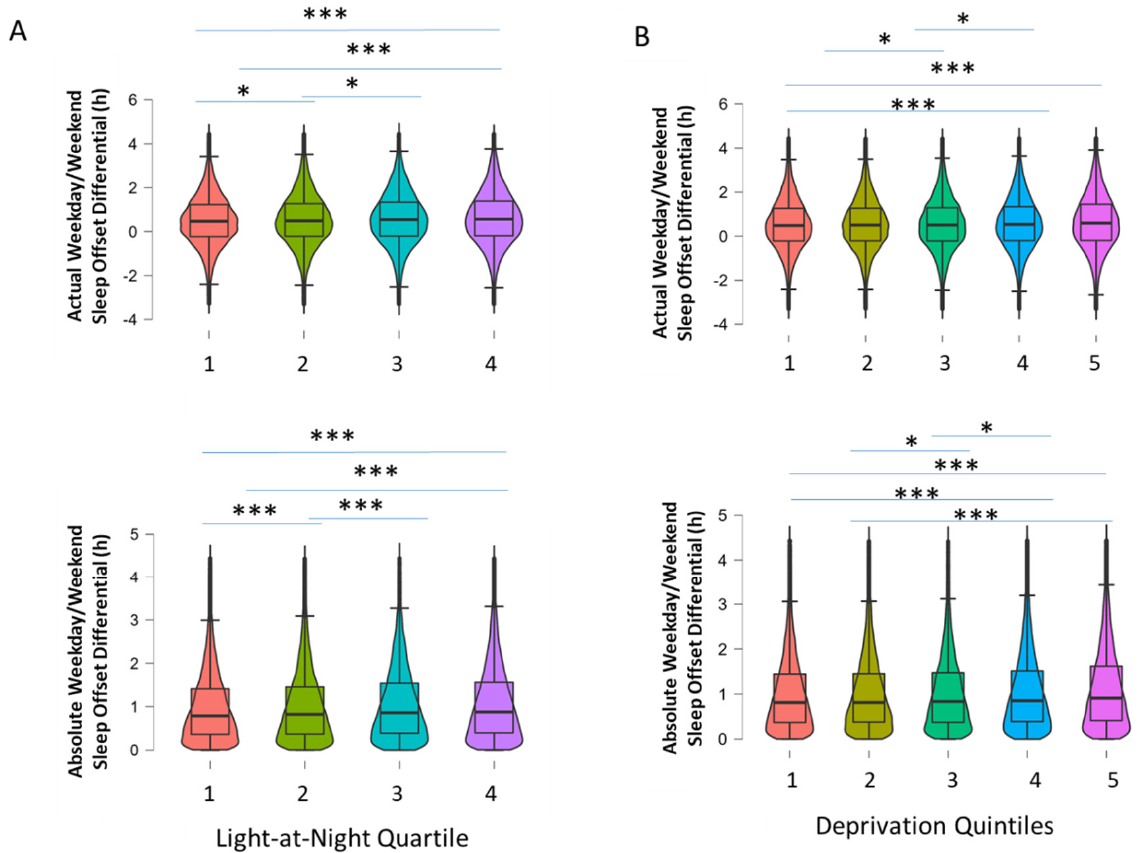
Figure 5. Box-and-violin plots showing ( A ) actual and absolute WD/WE according to light-at-night quartile grouping (1 = lowest LAN, 4 = highest LAN); ( B ) actual and absolute WD/WE according to quintiles based on Townsend Deprivation Index scores (1 = least disadvantaged, 5 = most disadvantaged). *** denotes p < 0.001, * p < 0.05 for pairwise comparisons (Tukey post hoc test following p < 0.001 for one-way ANOVA).